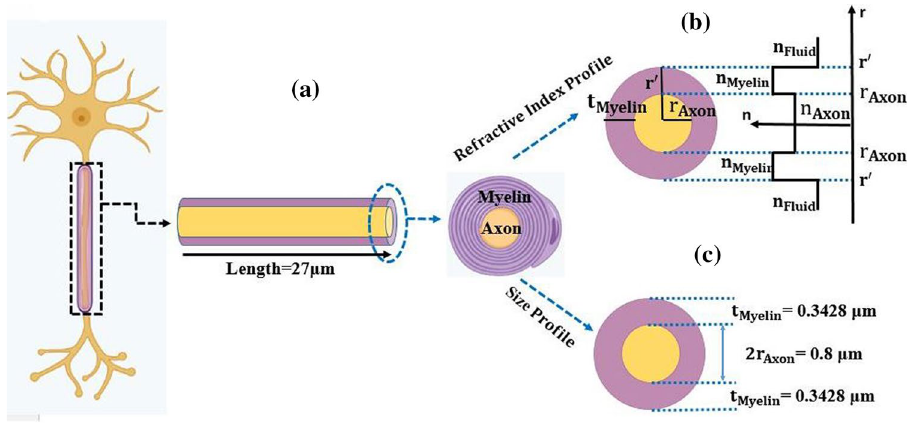
Figure 2. Schematic of structural and optical characteristics of a nerve fiber, ( a ) longitudinal cross-section circular cross-section, ( b ) RI profile and ( c ) the size of Myelin sheath and Axon when g-ratio = 0.7.